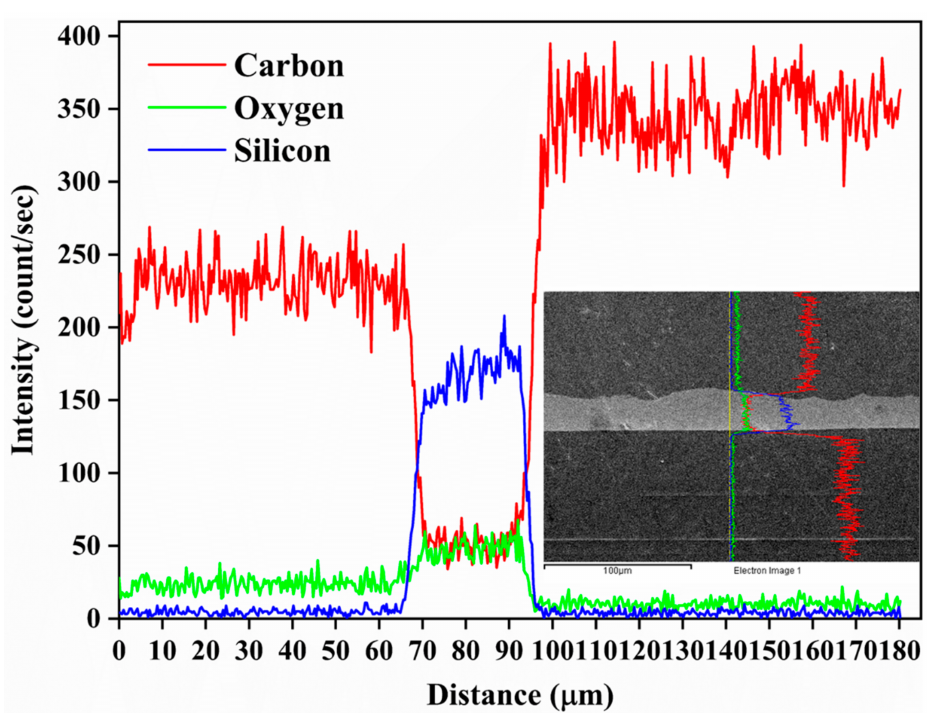
Figure 6. EDS result for chemical composition on the fabricated superhydrophobic coated films with a relative SNP weight ratio of